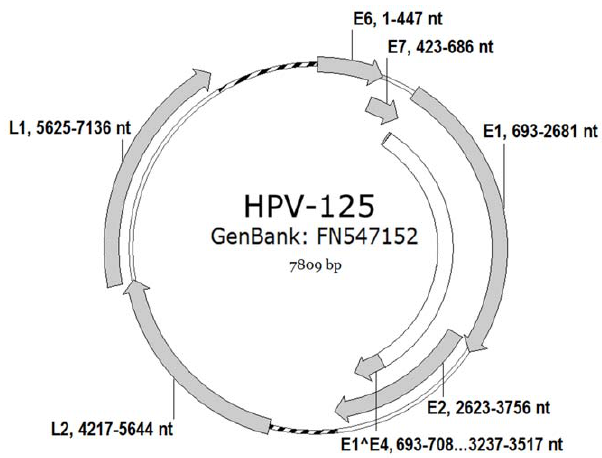
Figure 2. Genomic organisation of HPV-125. Genomic positions of viral genes E6, E7, E1, E2, E4 (E1 ‘ E4), L1 and L2 are indicated next to the respective gene. The non-coding regions located between L1 and E6 (LCR); and E2 and L2 are indicated with a dotted line. doi:10.1371/journal.pone.0022414.g002 Table 1. The nucleotide and amino acid sequences of the late genes L1 and L2 and the early gene E2 of HPV-125 showed the highest similarity to the corresponding genes of HPV-3. However, the early gene E7 of HPV-125 was more similar to E7 of HPV-28, than to E7 of HPV-3 (Table 1) in both nucleotide and amino acid sequences. The nucleotide sequence of the early gene E6 of HPV- 125 showed the highest similarity to E6 of HPV-3, while its amino acid sequence was slightly more similar to the E6 protein of HPV- 28. Similarly, the nucleotide sequence of the early gene E1 of HPV-125 showed the highest similarity to E1 of HPV-3, while the amino acid sequence was more similar to the E1 protein of HPV- 28. Given that HPV-3, HPV-28 and HPV-125 are the most closely related genotypes within Alphapapillomavirus species 2, this could either reflect a recombination event or a different